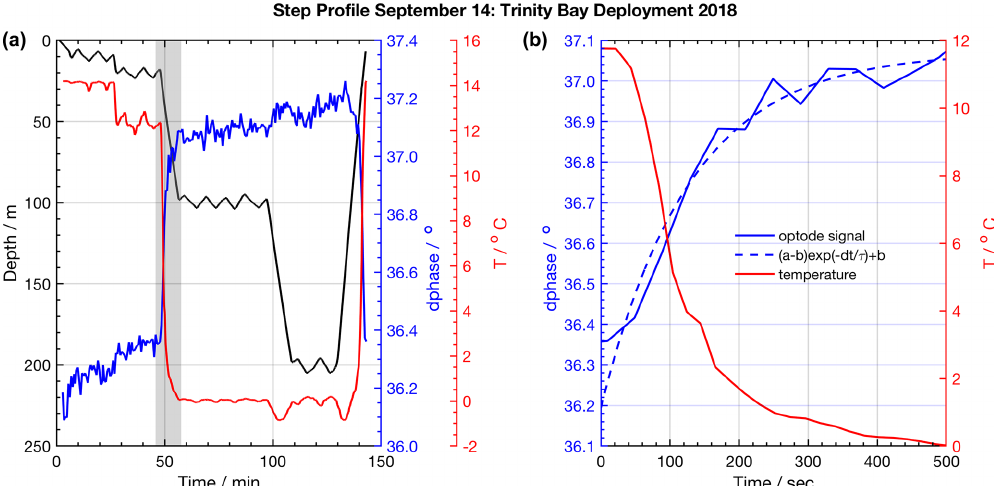
Figure 3. Example of a staircase profile used to quantify response time characteristics. (a) Glider staircase profile (black) overlaid with glider CTD temperature (red) and CO 2 optode signal (blue). The grey shaded area highlights an example episode of sensor response, shown in (b) , used to quantify the sensor response time and correct glider profiles. The exponential fit to the CO 2 optode response is shown (dashed blue line).